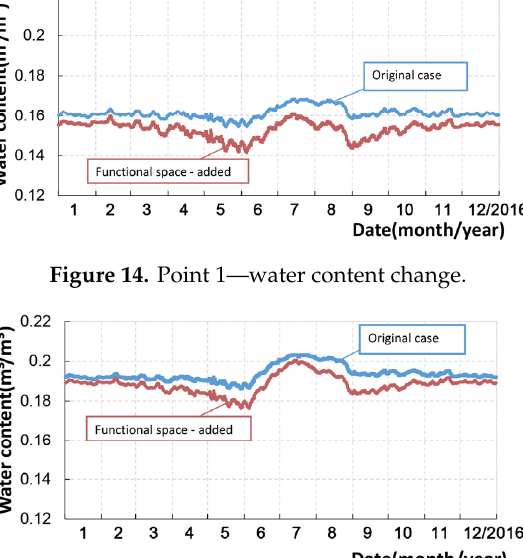
Figure 15. Point 2—water content change.